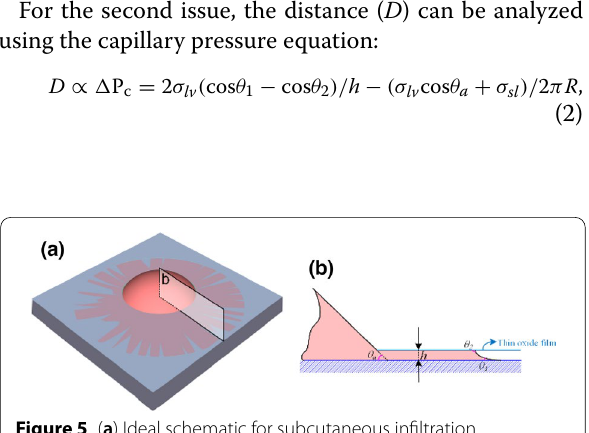
Figure 5 ( a ) Ideal schematic for subcutaneous infiltration mechanism and ( b ) cross-sectional view of ( a